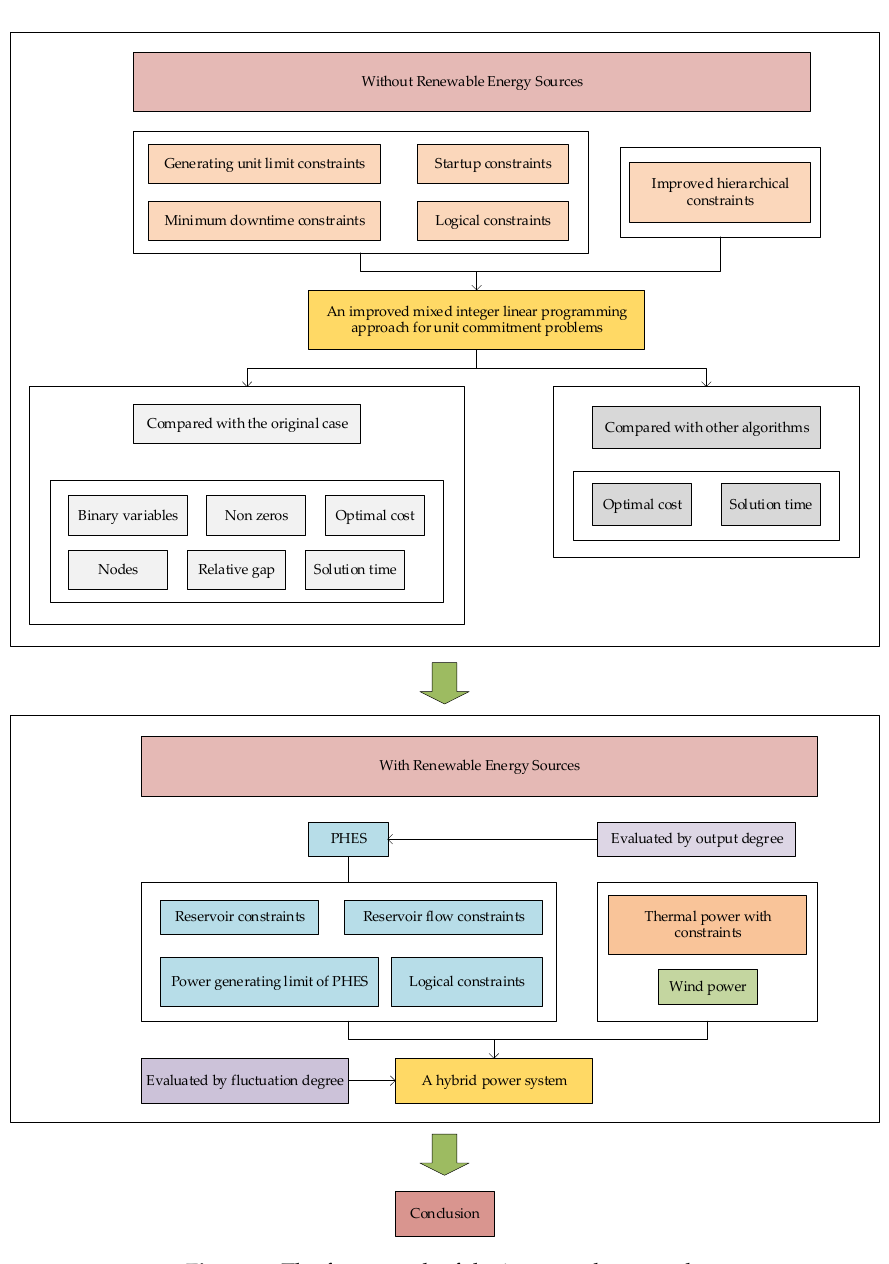
Figure 2. The framework of the improved approach.